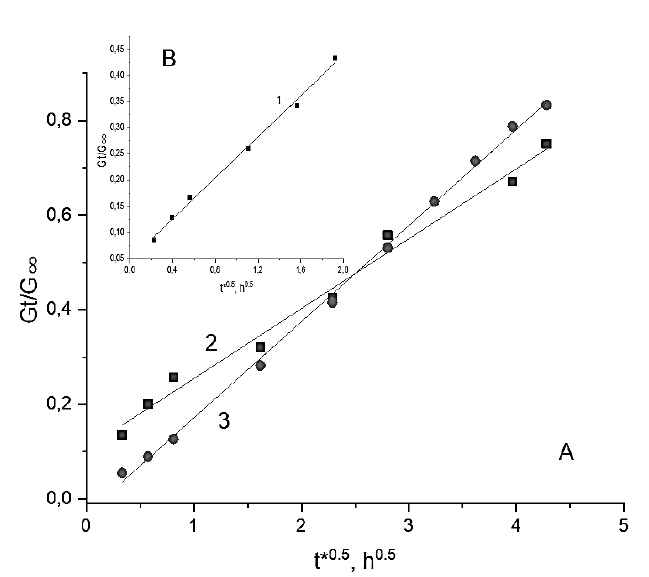
Figure 6. Diffusional impact on drug release for different polymeric systems: ( A )—PHB-microbeads (1), ( B )—the non-filled PVA cryogel (2) and the composite cryogel (3).